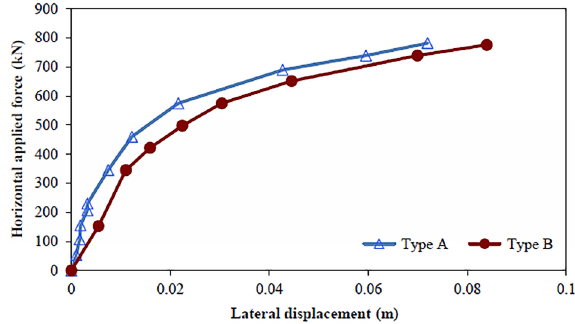
Figure 6. Lateral displacement versus applied horizontal applied force at top of column during loading in Stage 2